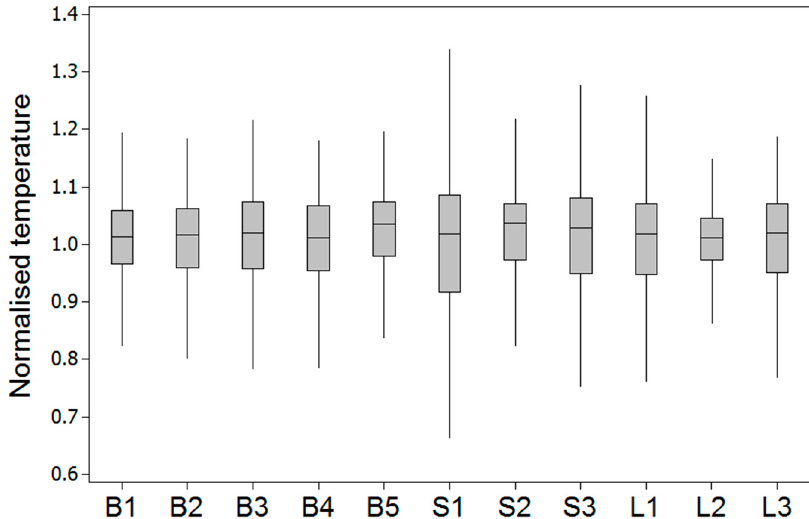
Figure 11. Ranges of observed normalised temperatures for each heat exchange configuration, with the median and quartiles indicated.